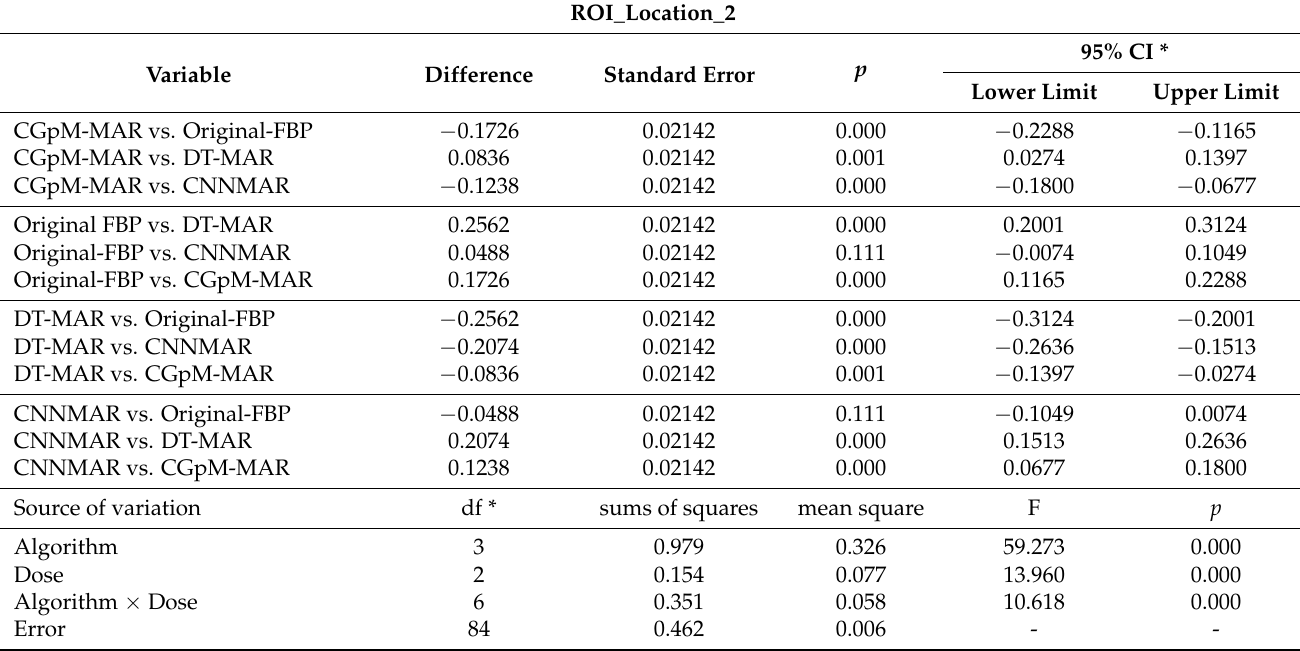
Table 2. Metal artifact reduction performances of tomosynthesis reconstruction algorithms. (dark artifact